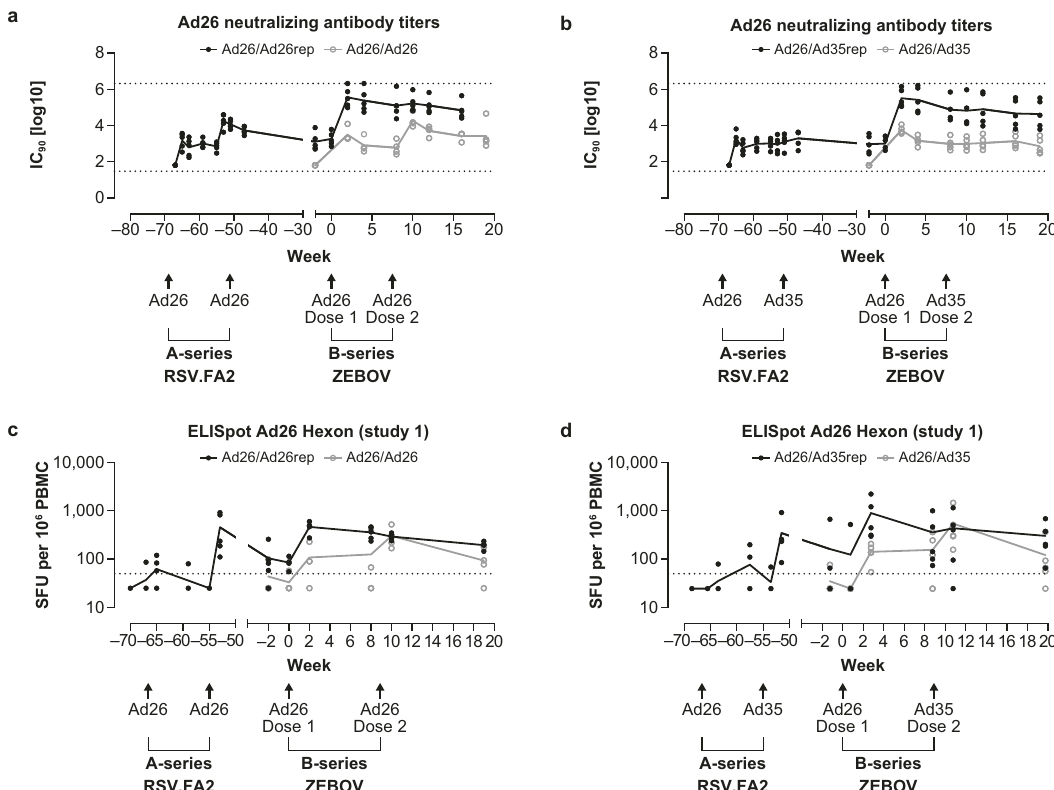
Fig. 2 Anti-Ad26 vector responses in animals dosed with Ad26 vectors. Ad26 ( a , b ) Nab titers were determined using an Ad26-based VNA with sera obtained from animals in the indicated groups from study 1. Each symbol represents 1 animal ( fi lled circle, animals dosed in A-series with Ad26; open grey circle, animals not dosed in A-series). Dotted lines depict ULoD (log10 highest serum dilution in the assay, 1/65536 for Ad26) and LLoD (log10 lowest serum dilution in the assay, 1/64 for Ad26), respectively. N = 4 to 5 animals per group ( c , d ). Ad26 hexon-speci fi c T-cell responses were measured by IFN γ ELISpot using PBMCs stimulated with peptide pools covering Ad26 hexon sequences. The dotted line corresponds to a threshold of 50 SFU/106 PBMCs. The horizontal lines represent the mean group response. Animals that received an Ad26 and/or Ad35 vaccine during the A-series are annotated as Ad26/Ad26rep or